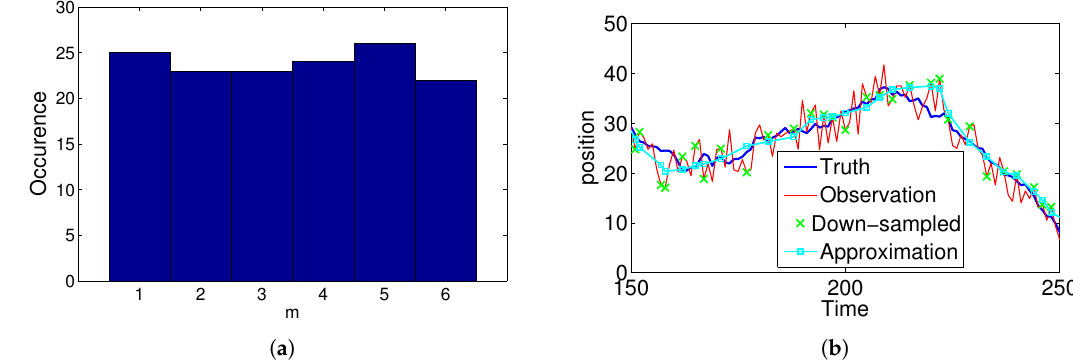
Figure 8. Performance of the filter when using non-uniform sampled data. ( a ) shows the histogram of sample times in the sequence, and ( b ) directly compares the observed and estimated trajectory, as well as the observed and non-uniformly down-sampled time